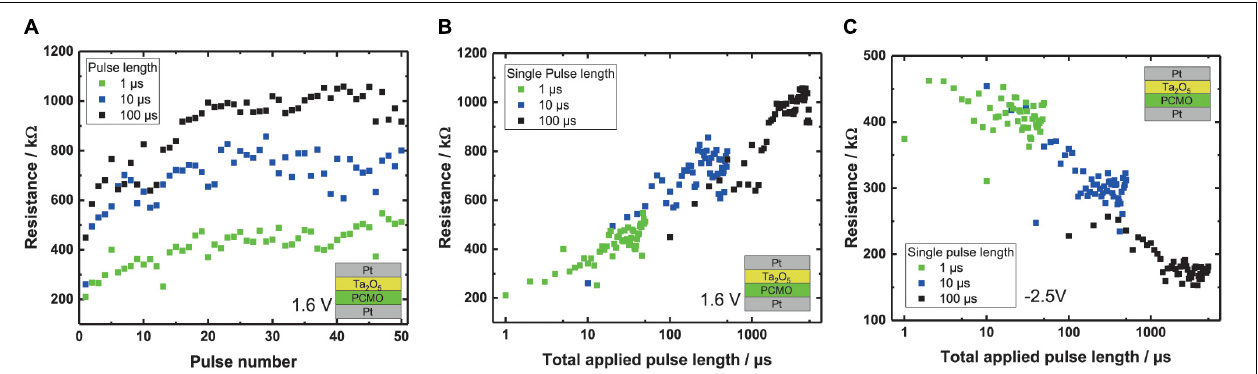
FIGURE 5 | (A) RPM of the Ta 2 O 5 devices with 1.6 V per pulse and different pulse lengths –1, 10 and 100 µ s. (B) Resistance of the RPM plotted against the total applied pulse length for three different pulse lengths with a pulse voltage of 1.6 V. (C) SPM curves of the Ta 2 O 5 devices with the resistance plotted against the total applied pulse length, with a pulse voltage of –2.5